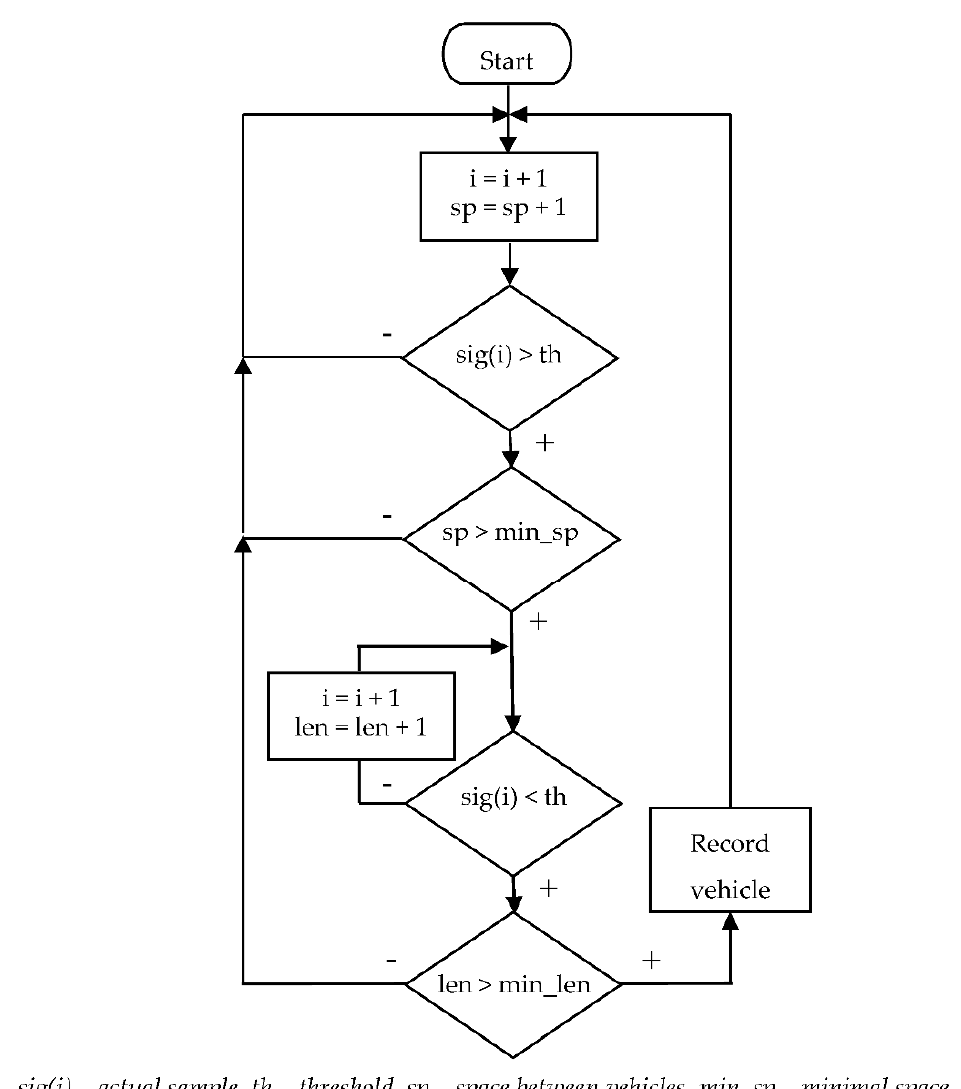
Figure 6. Detection algorithm principle.